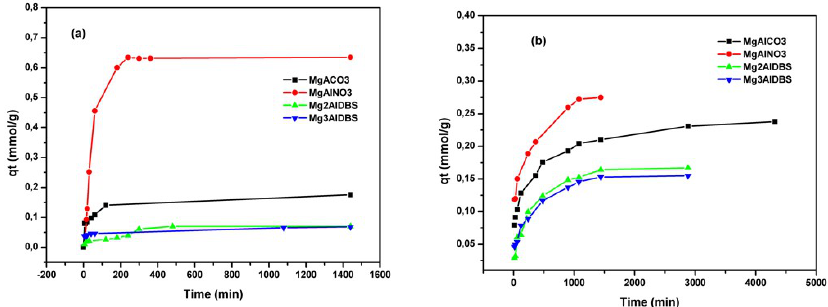
Figure 4. Evolution of dye adsorption on inorganic and nanohybrid LDH for: ( a ) amaranth and ( b ) DGB. qt (mmol/g) is the adsorption capacities of the absorbate at time t (min).